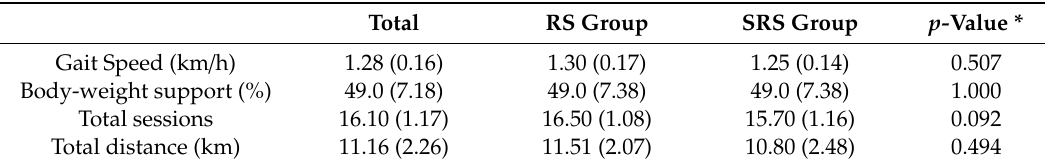
Table 2. Robot training parameter.